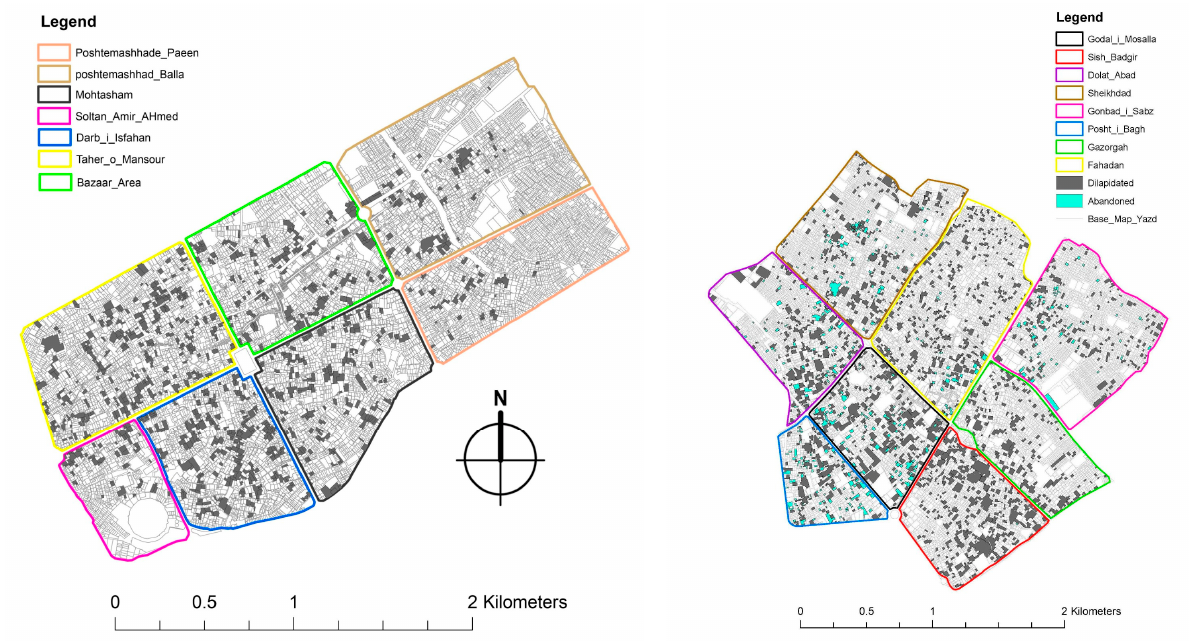
Figure 6. The seven urban tissues of historic Kashan as surveyed by Mirmiran (2011) ( left ) and the eight urban tissues of historic Yazd based on Behzadfar [11] ( right ).